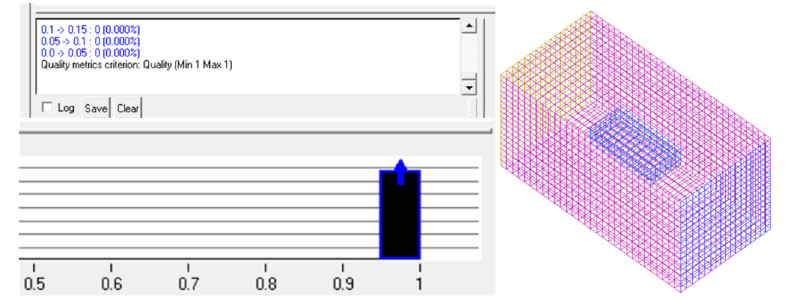
Figure 4. Physical meshing of freezers and pork.